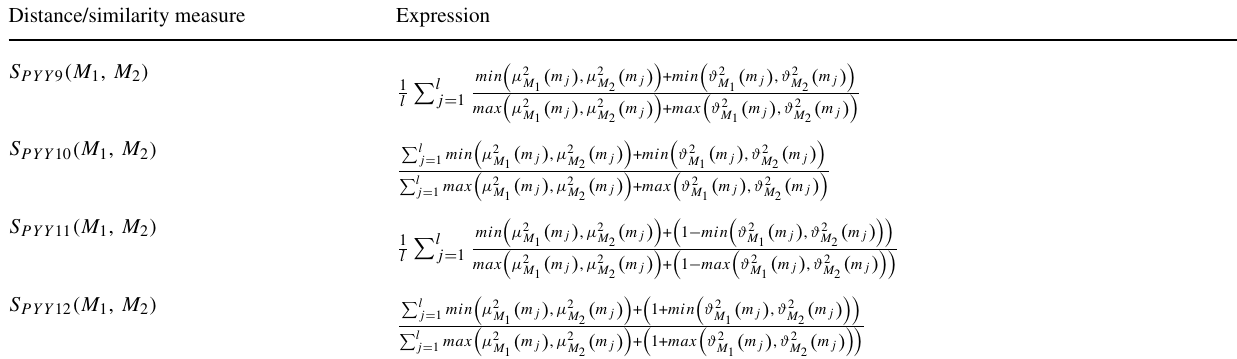
3. The PF distance measures D PYY 7 , D PYY 8 , D PYY 9 , and D PYY 10 gives “1” as the distance between the two dif- ferent PFSs (Case I) although they are not a complement of each other. 4. The PF similarity measures S PYY 1 , S PYY 4 , S PYY 5 , S PYY 6 , S PYY 9 , and S PYY 10 give the same degree of similarity for the two distinct cases (Case II and Case III).